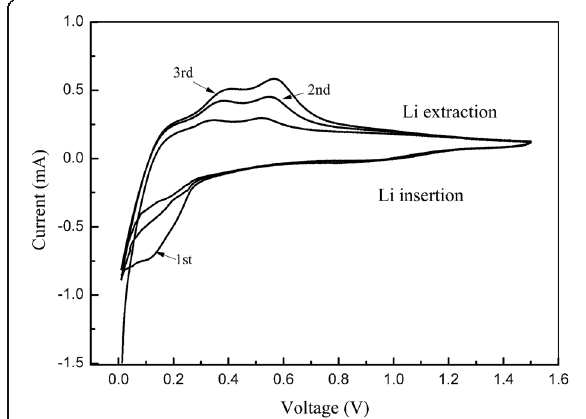
Fig. 8 Cyclic voltammetry of MR-Si-G composite from 0.01 V to 1.5 V at a scan rate of 0. 1 mV s − 1